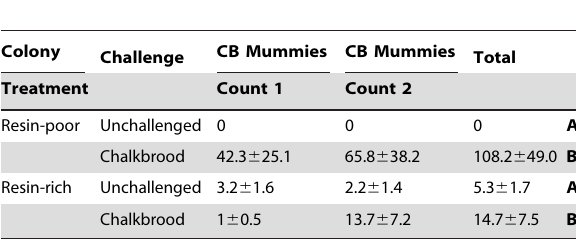
Table 1. Chalkbrood infection levels in colonies in